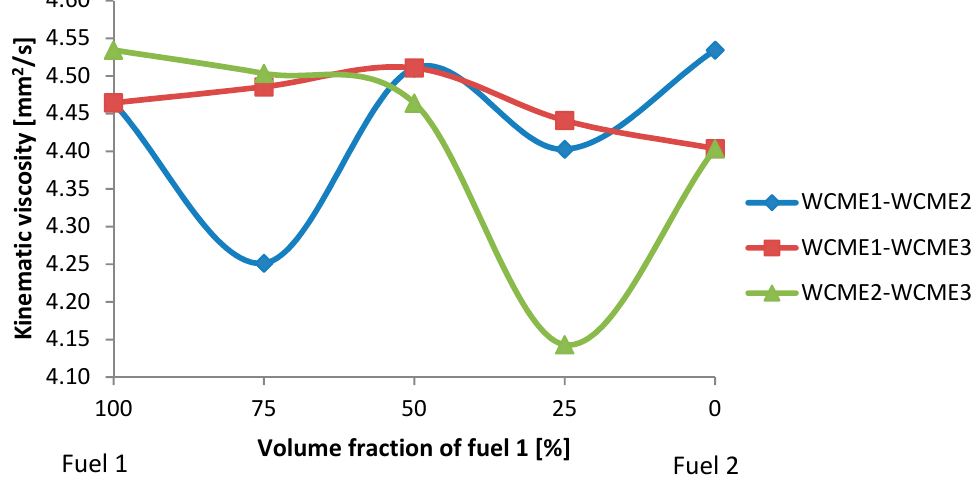
Figure 4. Kinematic viscosity versus volume fraction at a temperature of 40 ◦ C (WCME1-WCME2: WCME 1 and WCME2 are considered as fuel 1 and fuel 2; WCME1-WCME3: WCME 1 and WCME3 are considered as fuel 1 and fuel 2; WCME2-WCME3: WCME 2 and WCME3 are considered as fuel 1 and fuel 2).